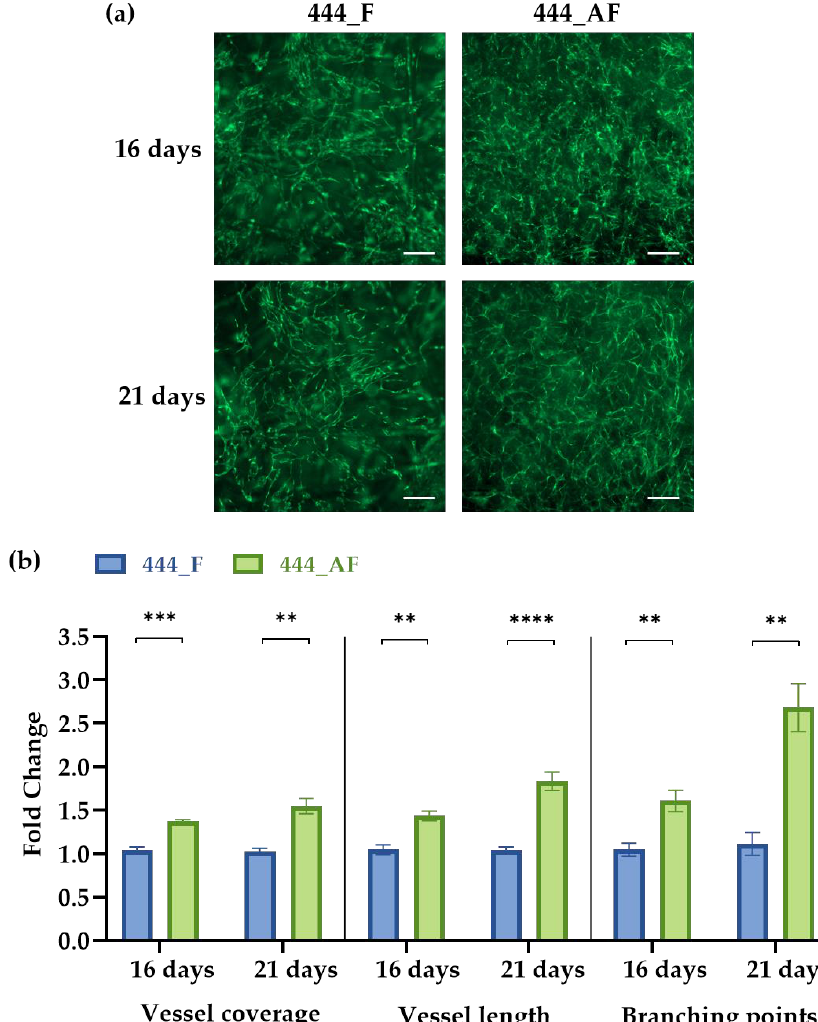
Figure 5. ( a ) Vessel network formation in 444_F and 444_AF scaffolds at days 16 and 21 of culture (scale bar—200 µm); ( b ) Measurements of vessel coverage, total vessel length and total branching points as determined by AngioTool. Data are presented in an x-fold expression of the corresponding 444_F values. Bars represent the mean ± standard error for each tested group ( n = 3 samples from each group). Statistical analysis was conducted by unpaired t test, ** p < 0.01, *** p < 0.001, **** p < 0.0001.